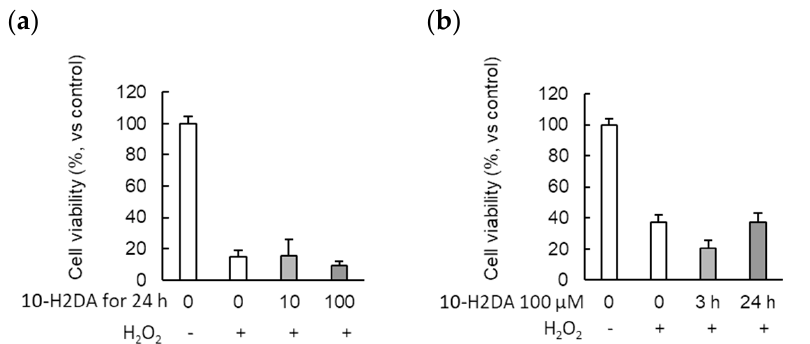
Figure 3. Effects of 10-H2DA on cell viability. ( a ) Astrocytes ( n = 8) were treated with 10-H2DA (10 µ M and 100 µ M) for 24 h. ( b ) Astrocytes ( n = 8) were treated with 10-H2DA (100 µ M) for 3 and 24 h. Cells were then exposed to H 2 O 2 -induced oxidative stress (100 µ M) for 3 h. Control values in both ( a ) and ( b ) were obtained in the absence of H 2 O 2 and 10-H2DA. Data represent the mean ± SEM (* p < 0.05 vs. H 2 O 2 control, one-way ANOVA followed by Tukey’s post hoc test). H 2 O 2 treatment is indicated by + and absence of H 2 O 2 is indicated by